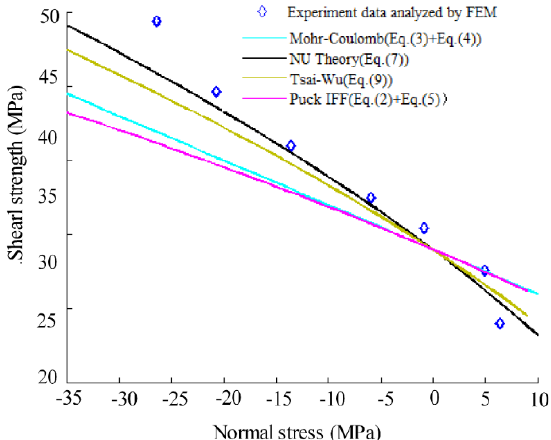
Figure 17: Comparison of failure criteria and experimental data analyzed by